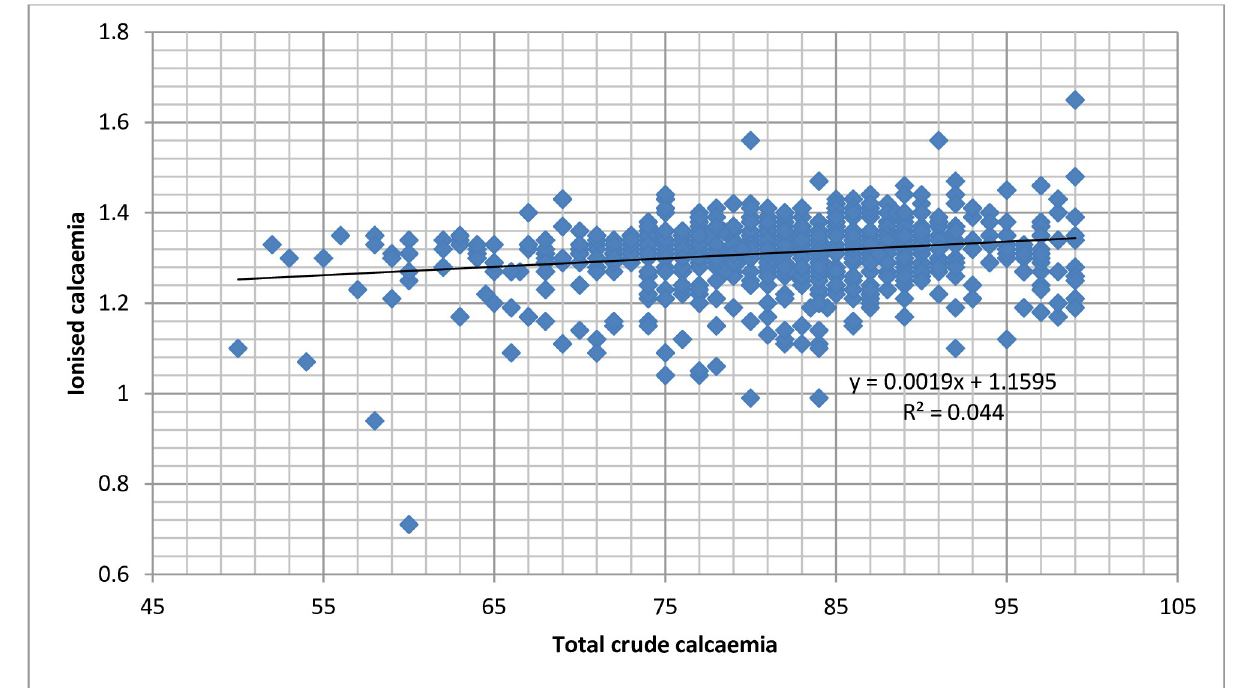
Fig 1. Plot of the relationship between ionised calcaemia and total crude calcaemia in pregnancy.